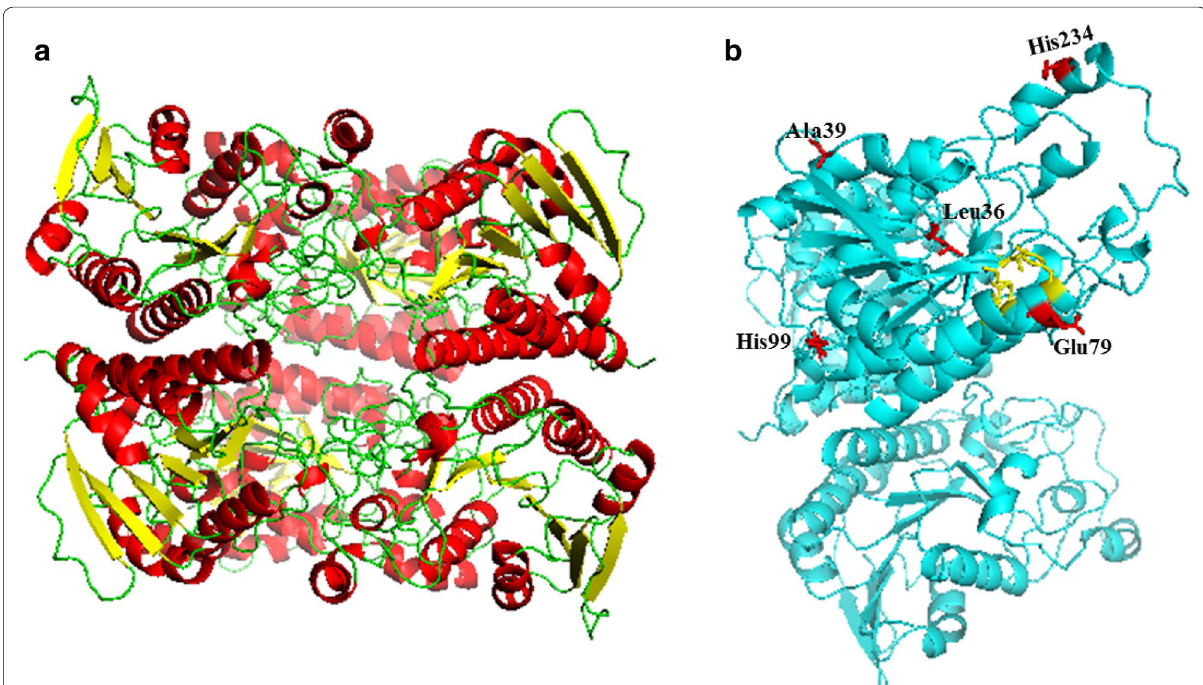
Fig. 2 Structural model of AtLBA4404 UDH. a Cartoon representation of the overall AtLBA4404 UDH structure. b The mutated amino acids are shown in red, the catalytic center in yellow (86Asn, 109Ser, 134Tyr, 138Lys)